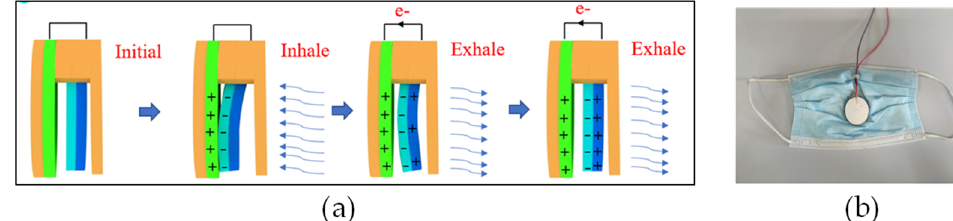
Figure 4. ( a ) Working mechanism of a mask − based respiration sensor [187]. Reproduced with permission from Elsevier. ( b ) Image of a triboelectric component integrated into a face mask [187]. Reproduced with permission from Elsevier.